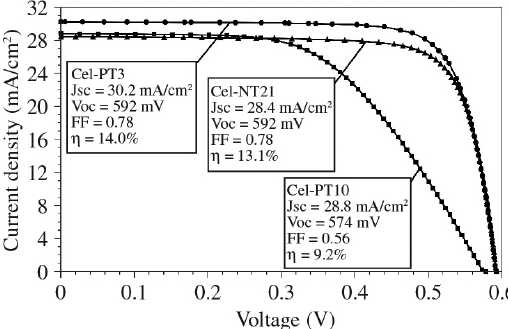
Figure 7. Current density as a function of the voltage of the solar cells Cel-PT03 (n + pp + ), Cel-PT10 (n + pp + ) and Cel-NT21 (n + pn + Table 3. Electrical parameters for n + pn + and n + pp + solar cells with 240 μm thickness as a function of the base resistivity of the Si-Mc substrate. Resistivity ( Ω .cm)